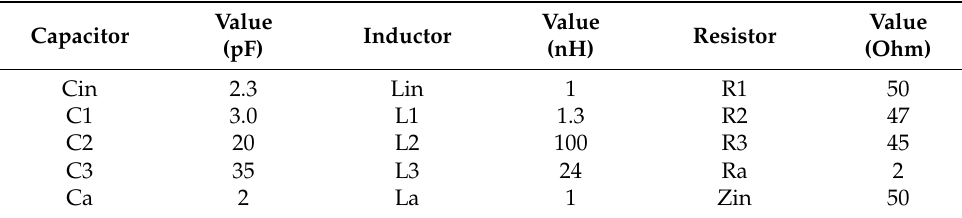
Figure 7. Front and back view of the fabricated prototype of the antenna.